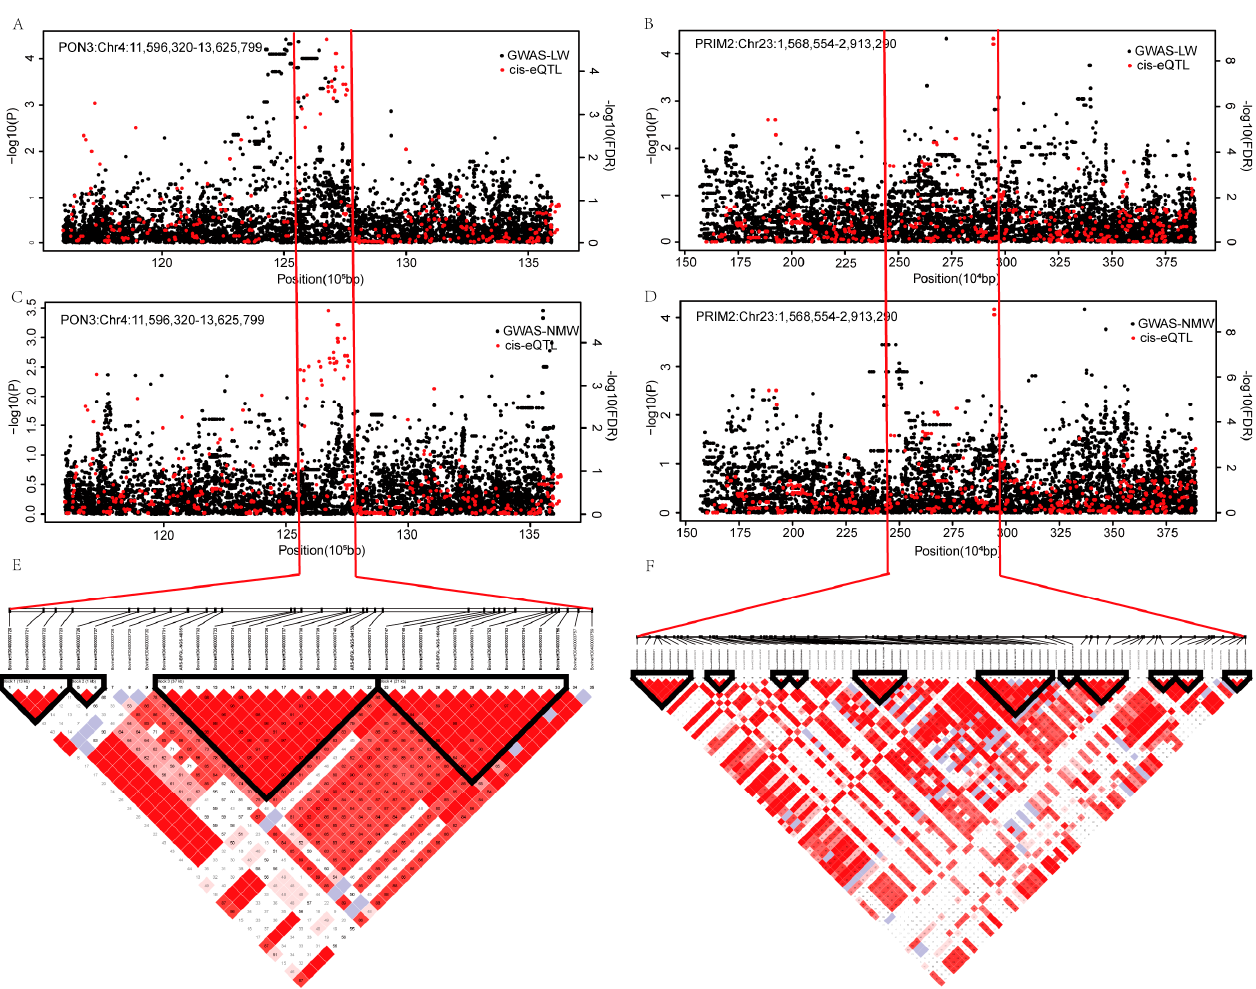
Figure 3. ( A – D ) The scatter diagram of SNPs within 1Mb upstream and downstream of the PON3 and PRIM2 from the previous GWAS and cis-eQTL results. Y-axis on the left side of the chart is the − log 10 (P) of the GWAS result, and on the right side is the − log 10 (FDR) of the cis-eQTL result. ( E ) The LD block from BovineHD0400003730 to BovineHD0400003759 in PON3 . ( F ) The LD block from BovineHD2300000469 to BovineHD2300000550 in PRIM2 .